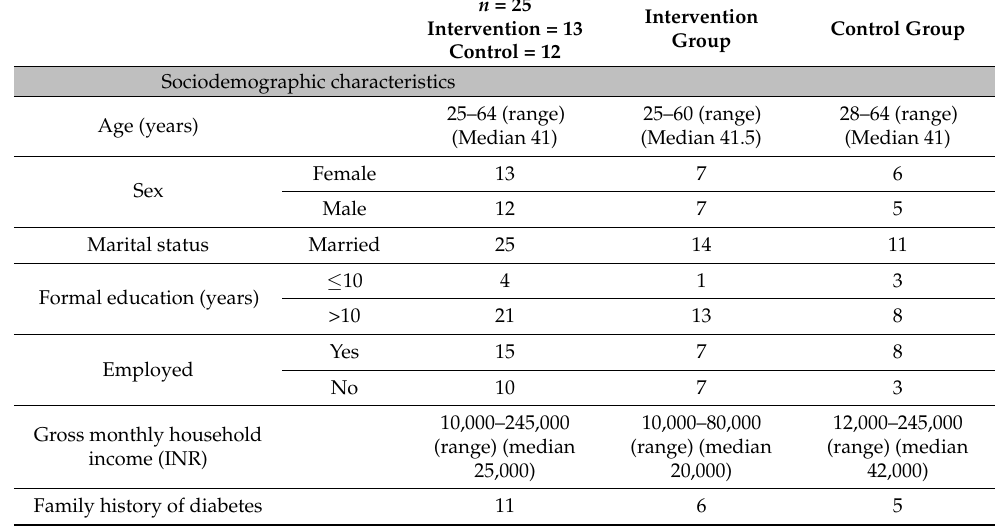
Table 1. Sociodemographic details of participants.